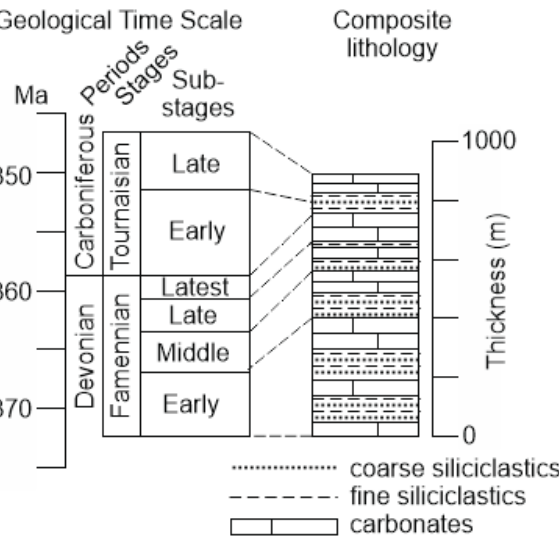
Figure 2. Stratigraphical framework of the Devonian–Carboniferous transition in the study area (created by the authors; the geological time scale follows [29], and the regional stratigraphy is compiled from [25–27]).